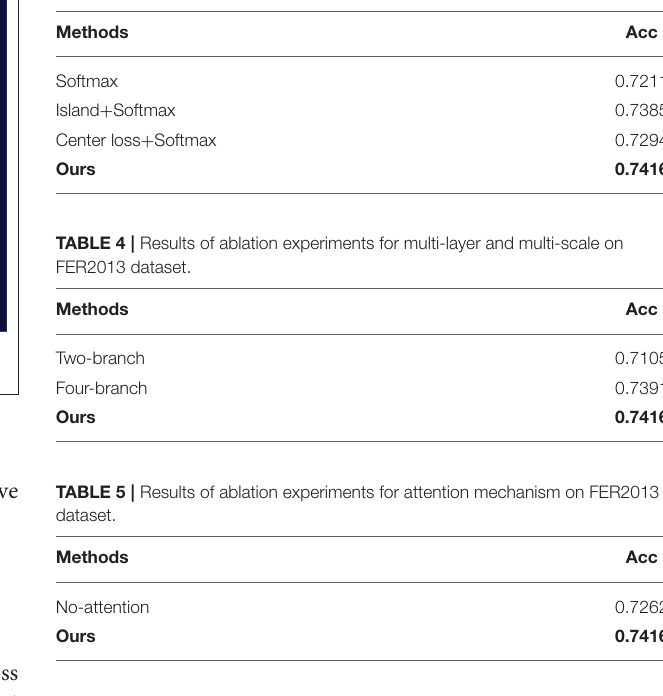
TABLE 3 | Results of ablation experiments for different loss functions on FER2013 dataset.